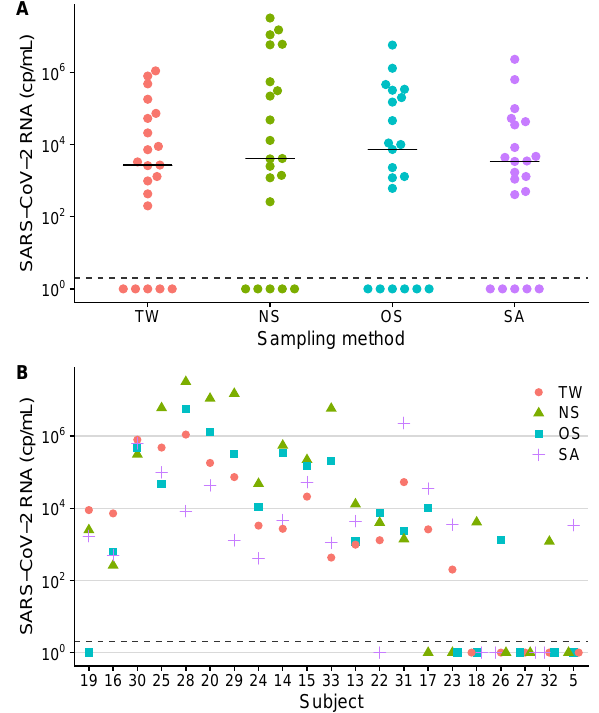
Figure 2. SARS-CoV-2 RNA concentrations in samples of 21 study participants. Measurements are separated into sampling site groups (TW, throat washing; NS, nasopharyngeal swab; OS, oropha- ryngeal swab; SA, saliva). Connected datapoints represent results from one patient. Samples with the result not detected were set to 10 0 cp/mL and are plotted below the dashed lines. ( A ) Levels of SARS-CoV-2 viral loads across sampling sites. The respective median concentrations are shown as horizontal lines. No statistically significant differences between the four sampling groups were found by linear mixed-effects model analysis. ( B ) comparative SARS-CoV-2 RNA quantification plots, sorted by concentration pattern and decreasing median viral load. Subject identification numbers are indicated on the